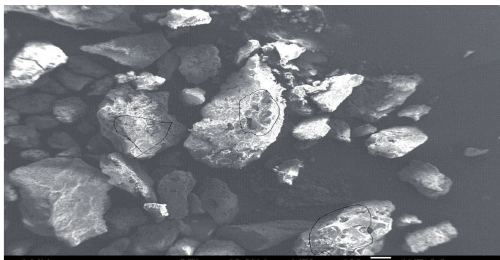
F 1: SEM image of MVM.